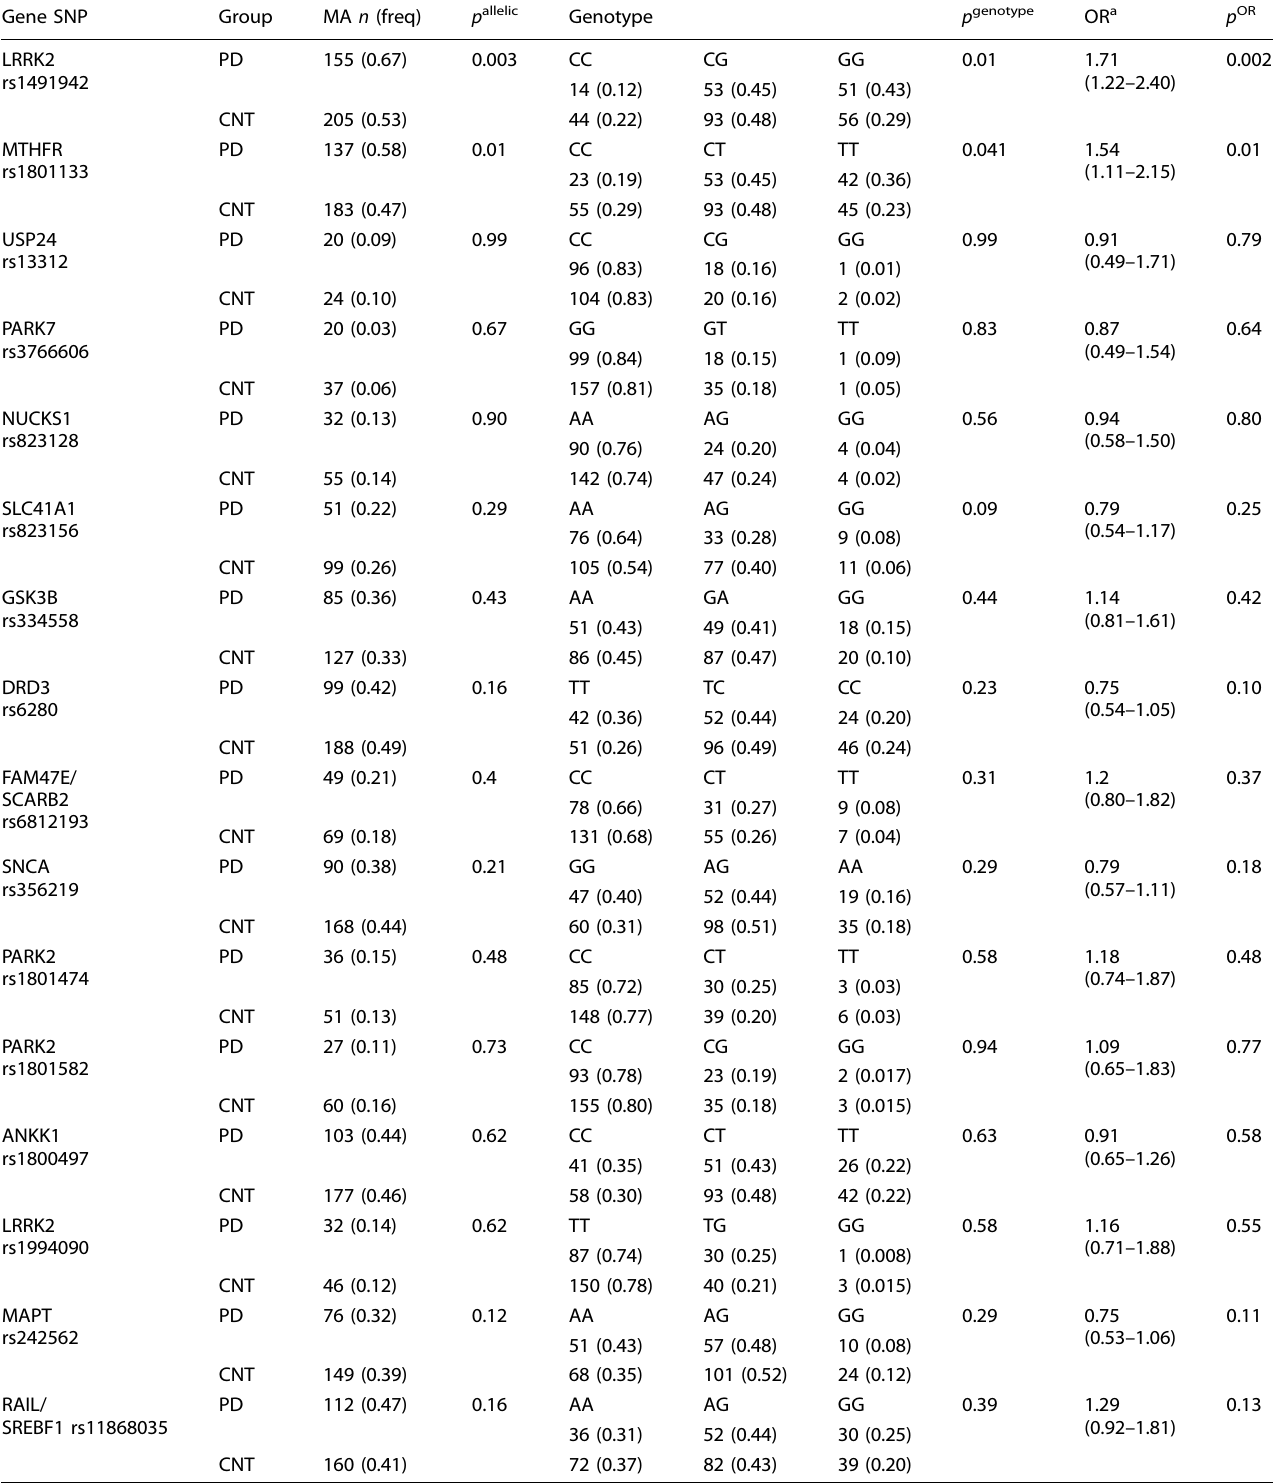
Table 2. Allele and genotype frequencies in PD patients and